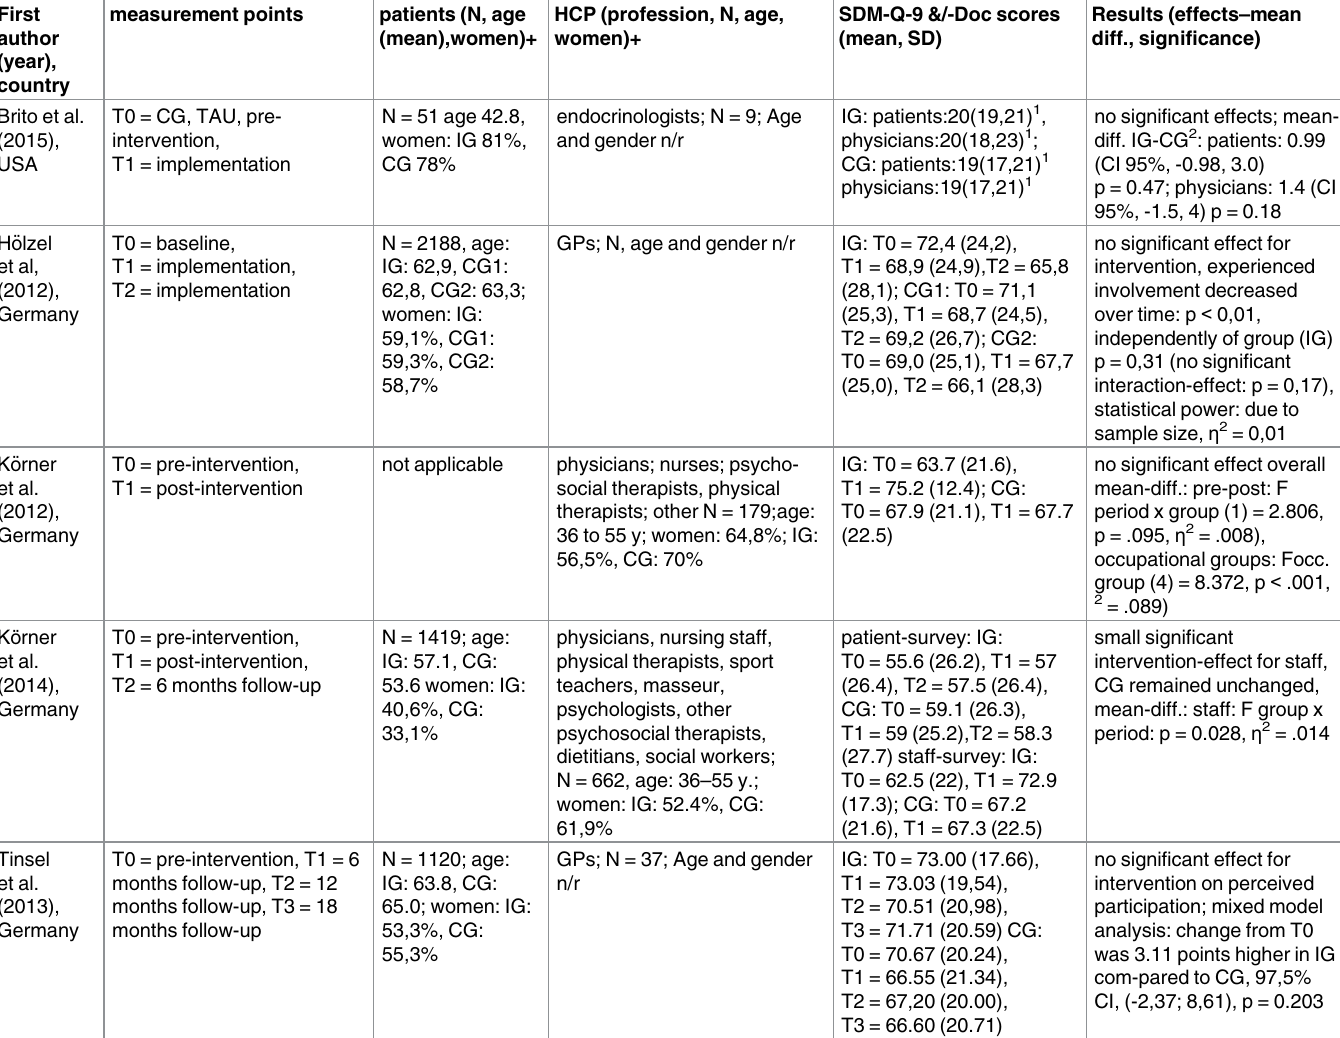
Table 3. Characteristics of the included original studies